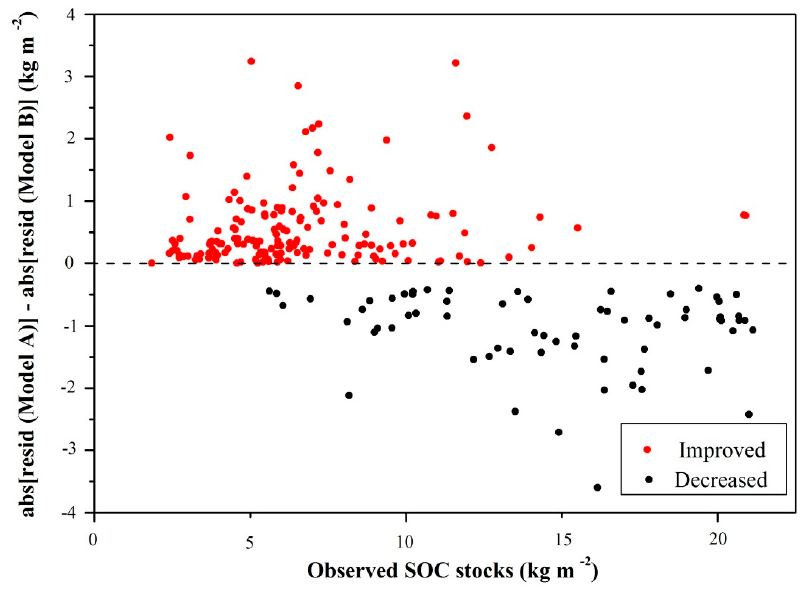
Figure 3. Di ff erence of absolute residual values between full variable model (Model A) and only topographic and climatic variables model (Model B). Decreased: prediction accuracy decreased; Improved: prediction accuracy